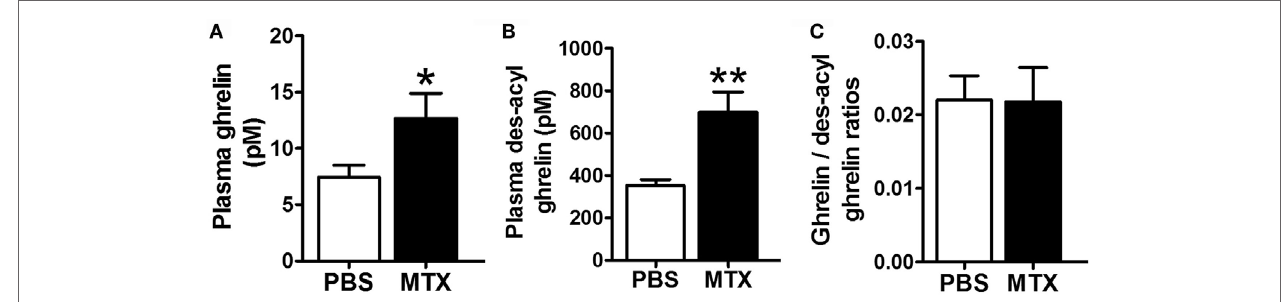
FigUre 3 | Plasma concentrations of ghrelin (a), des-acyl ghrelin (B), and their ratios (c) in PBs-treated controls ( n = 8) and MTX-treated ( n = 10) . * p < 0.05, Mann–Whitney test, KS test p = 0.03 and p > 0.1 and ** p < 0.01 Student’s t -test, KS test p > 0.1 both (mean ±